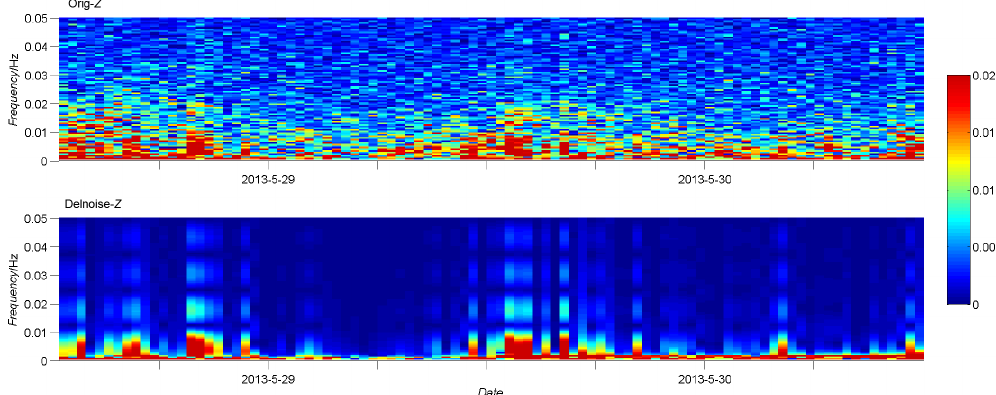
Figure 6. Spectrum of the original geomagnetic signal and the filtered data ( Z